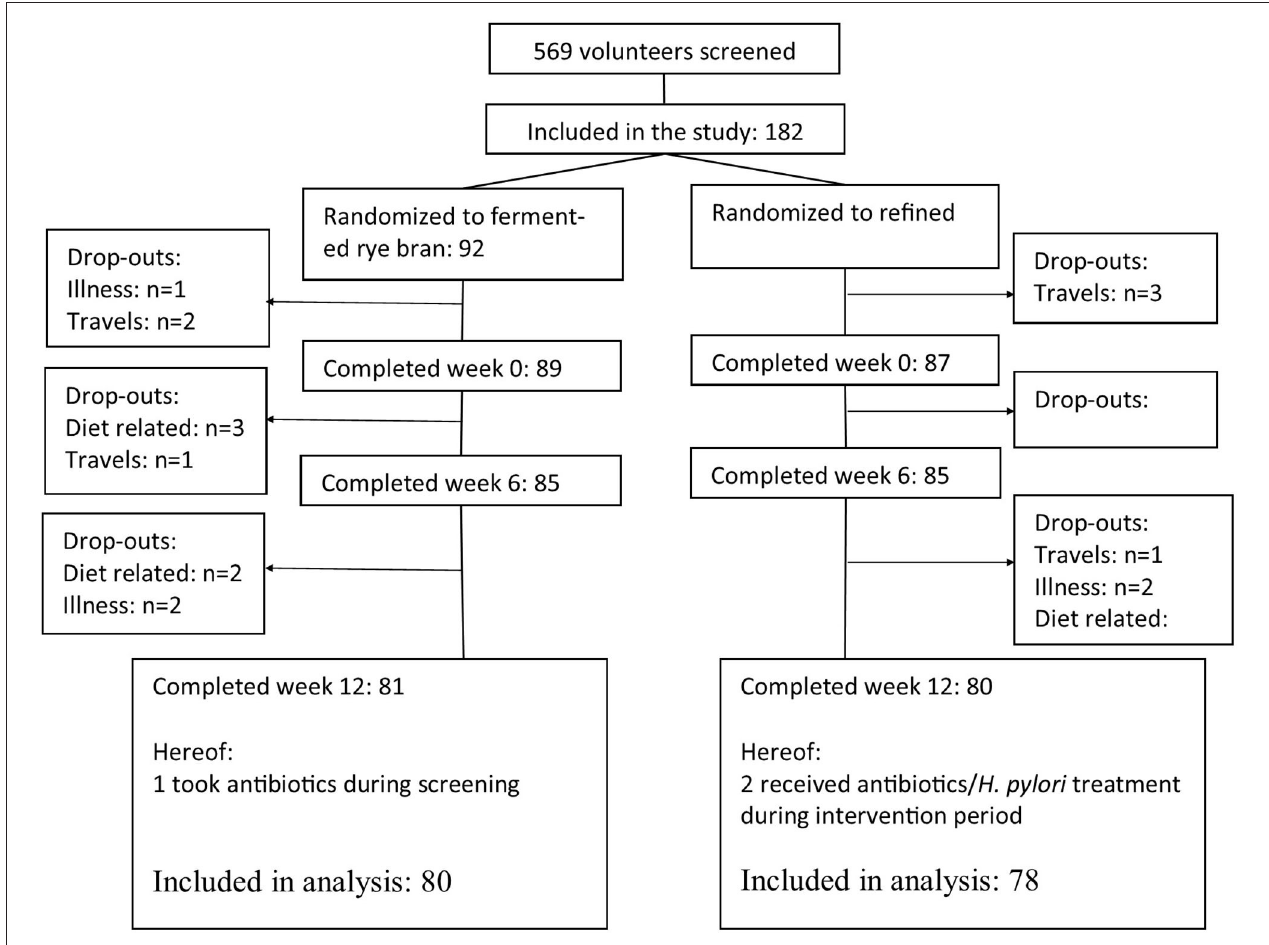
FIGURE 1 | Flow sheet of